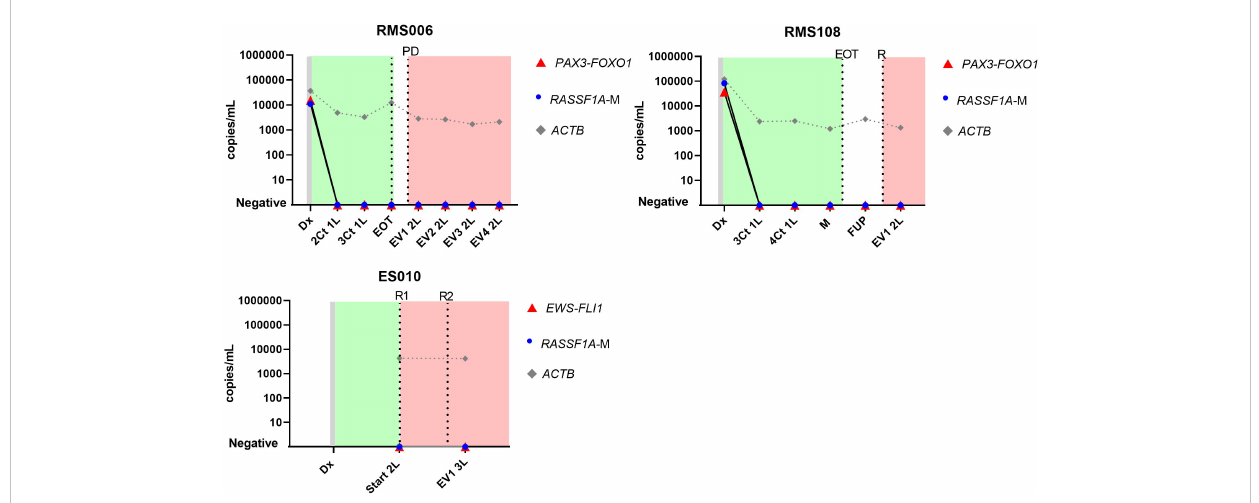
FIGURE 5 Levels of patient-speci fi c targets, reference gene ACTIN beta (ACTB) and methylated RASSF1A (RASSF1A-M) in cell-free DNA (cfDNA) in 2 patients with rhabdomyosarcoma (RMS026 and RMS092) and 1 patient with Ewing sarcoma (ES010) at diagnosis and during the course of the disease. Dx, diagnosis; nCt 1L, after n courses in fi rst line therapy; M, maintenance; FUP-follow up; EVn 2L, evaluation number n during second line therapy; EOT, end of treatment; R, relapse; Start 2L, start second line therapy; R, relapse; PD, progressive disease. Green blocks indicate fi rst line treatment, red blocks indicate treatment for progressive or relapsed